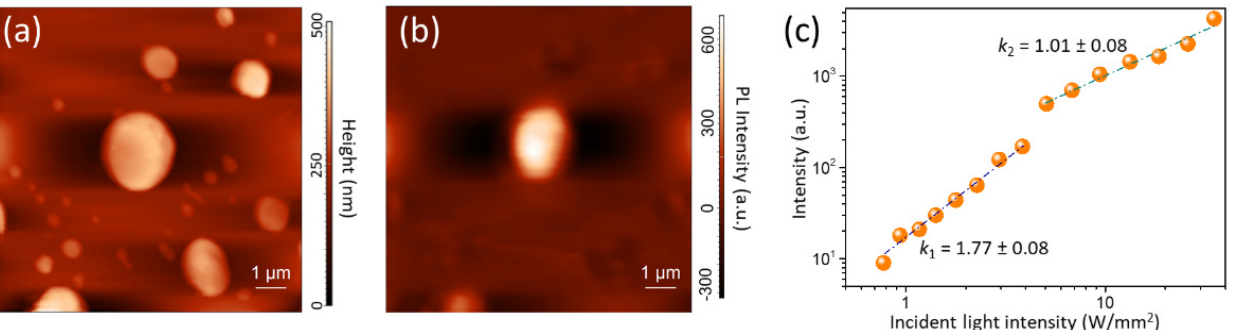
Figure 2. ( a ) Morphology and ( b ) PL-SNOM image of sample A acquired in transmission mode; ( c ) PL intensity in sample A as a function of the fluence of the incident radiation, acquired in transmission mode. The dashed lines are the results of the linear regression procedure using a power-law function for each selected range of the incident light